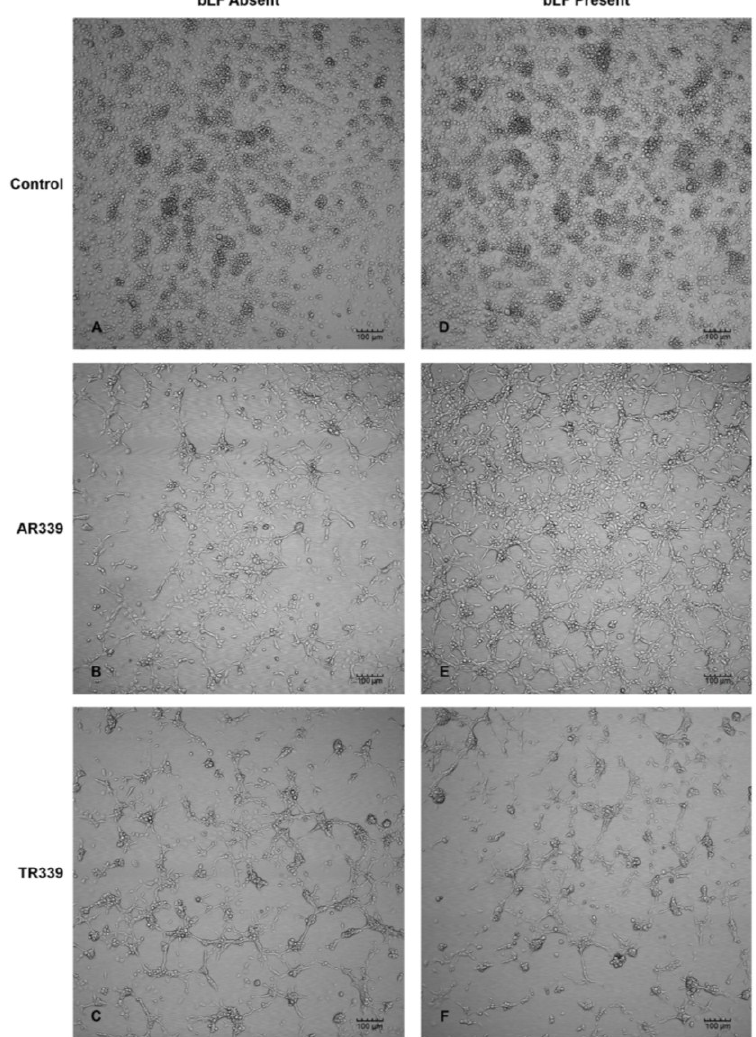
Figure 4. Inhibition of SINV-associated CPE in C7-10 mosquito cells at 48 h p.i. in response to bLF. ( A , D ) Controls, no virus added. Cells remain healthy in the absence of bLF ( A ) and after addition of 200 µg/mL of bLF ( D ); ( B , E ) SINV challenge using AR339 (M.O.I. of 0.1). CPE is observed in cells infected with AR339 in the absence of bLF ( B ), but CPE is less extensive following addition with 200 µg/mL of bLF ( E ); ( C , F ) SINV challenge using TR339 (M.O.I. of 0.1). Equivalent CPE is observed in the absence of bLF ( C ) and in the presence of 200 µg/mL of bLF ( F